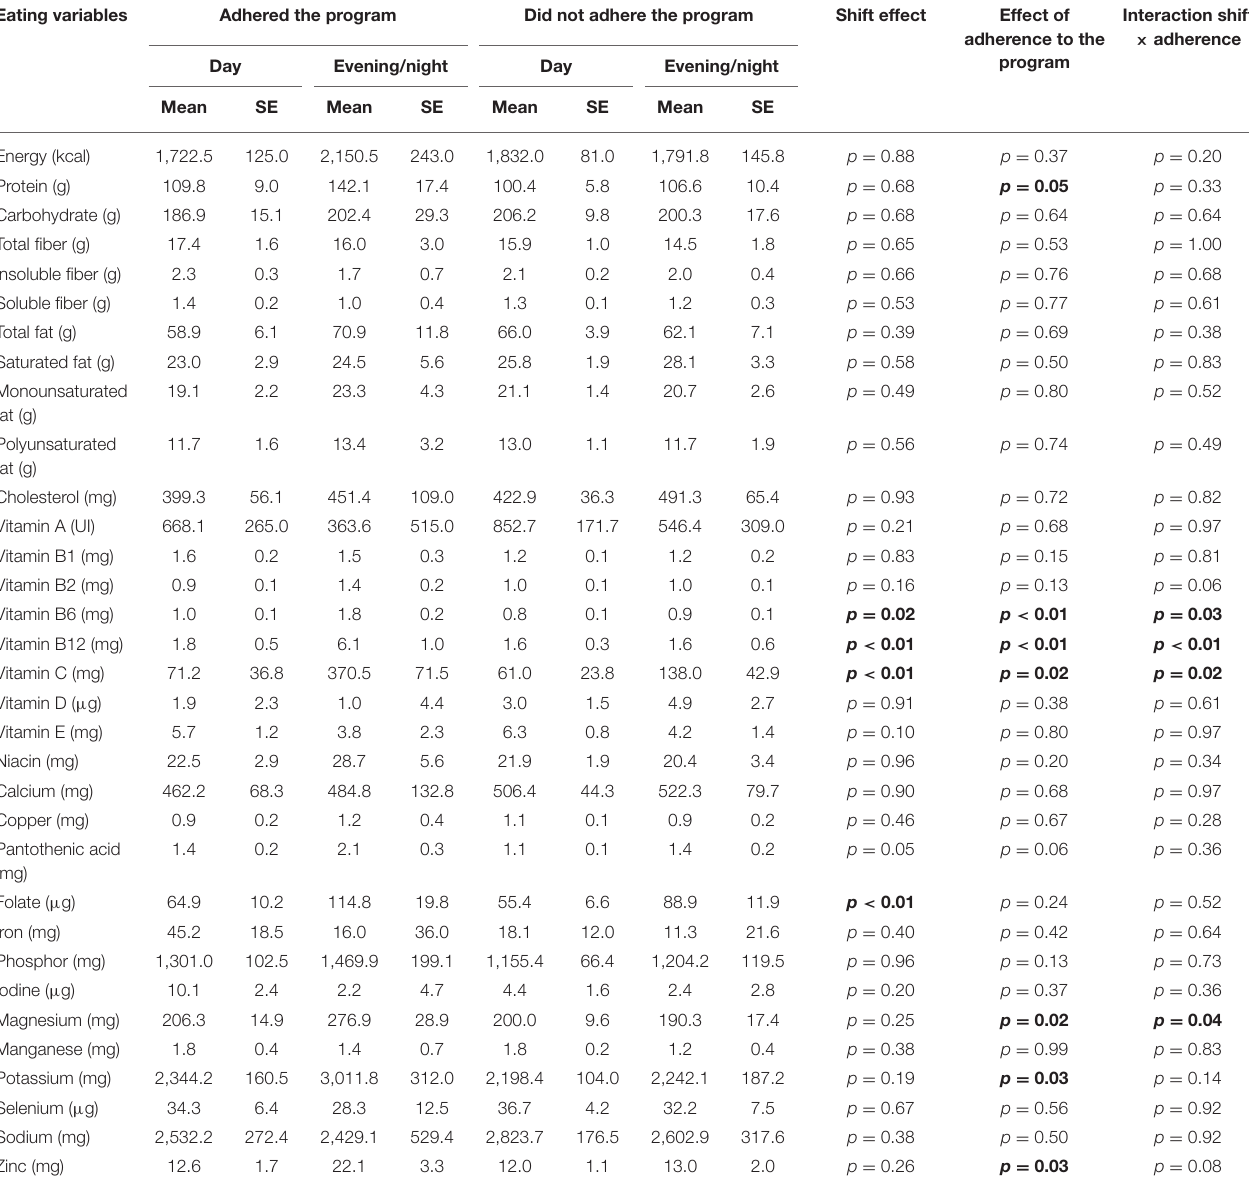
TABLE 4 | Generalized linear model of variables related to nutrient consumption during the pandemic period according to adherence to dietary program per work shift, adjusted for age and sex. Eating variables Adhered the program Did not adhere the program Shift effect Effect of